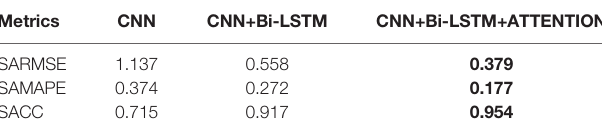
TABLE 2 | Twelve-hour performance